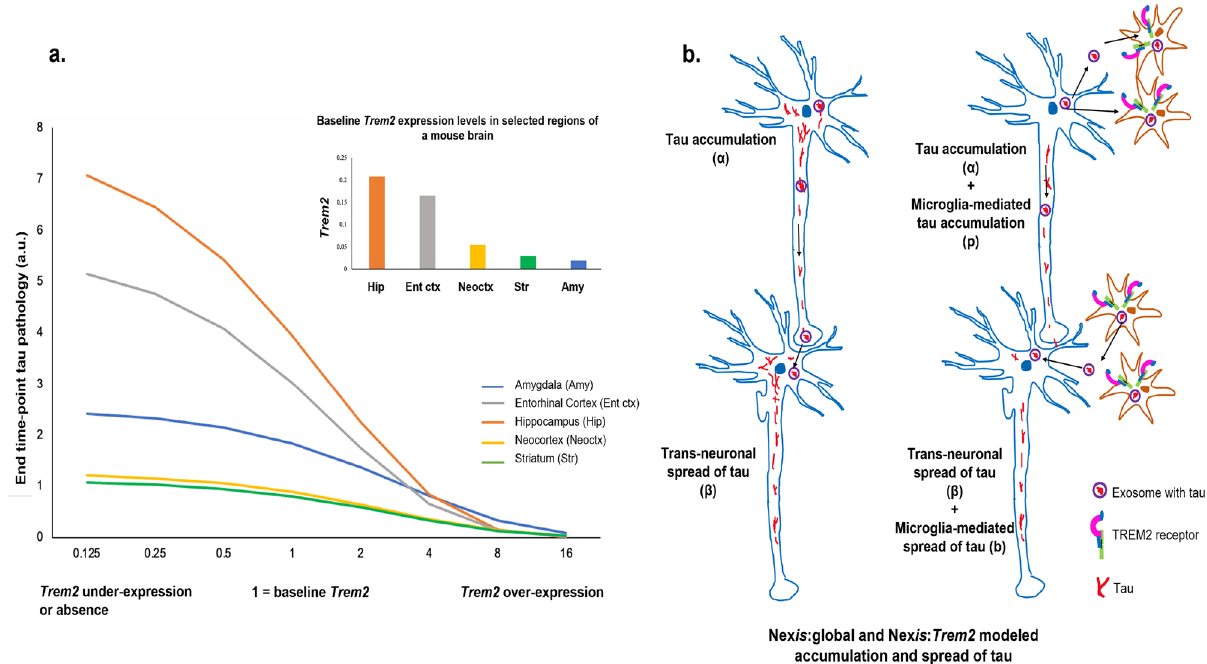
Figure 6. Summary of the relationship between Trem2 and tau. Panel ( a ): End time-point (12 weeks here) tau levels in response to simulated scaling of Trem2 expression levels in selected regions of the mouse brain. The inset depicts the baseline expression levels of Trem2 in the selected brain regions. Panel ( b ): Summary of the effect of Trem2 on tau accumulation and spread as modeled by Nex is : Trem2 . The rate of tau accumulation (parameter p ) was lower and the rate of tau spread (parameter b ) was higher in the presence of Trem2 . Nex is :global, which does not consider the effect of microglia, failed to capture the entire dynamics of tau, leading to poor model performance. Note that the illustrated relationship depends on the strain of tau being modeled. Note also that our speculation of exosomes contributing to trans-neuronal and microglia-mediated spread of tau has not been modeled using Nex is